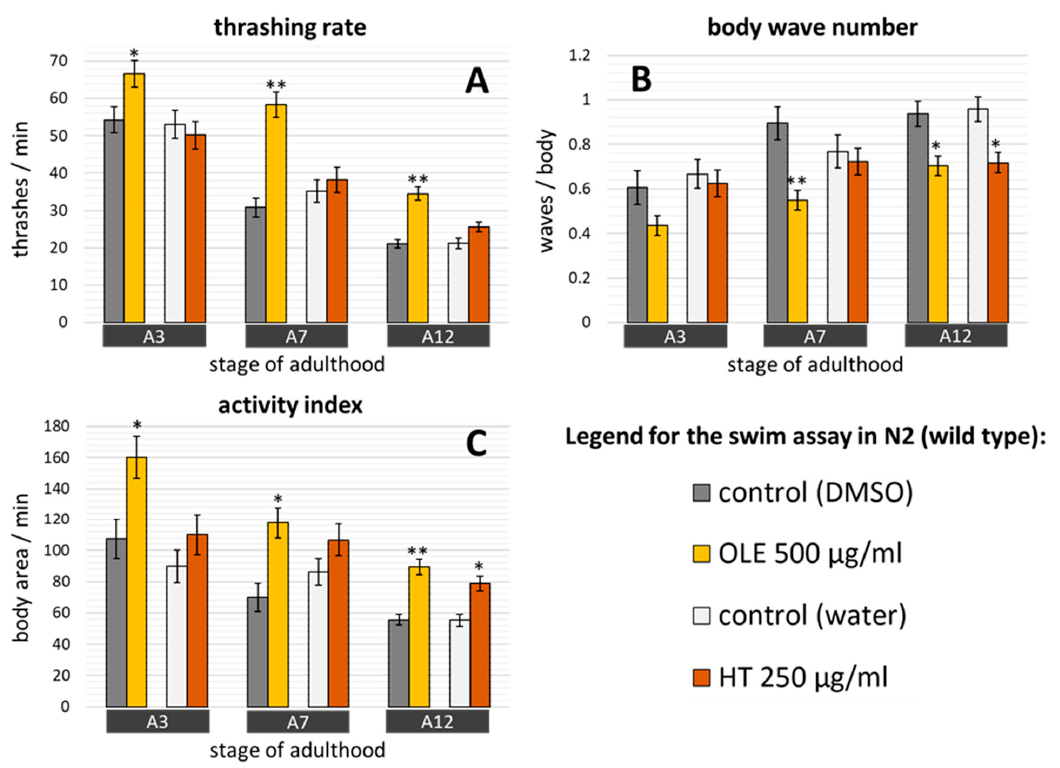
Figure 5. Swim behaviour characteristics in wild type C. elegans treated with OLE and HT. Locomotory performances were determined at day 3, 7, and 12 of adulthood in two independent